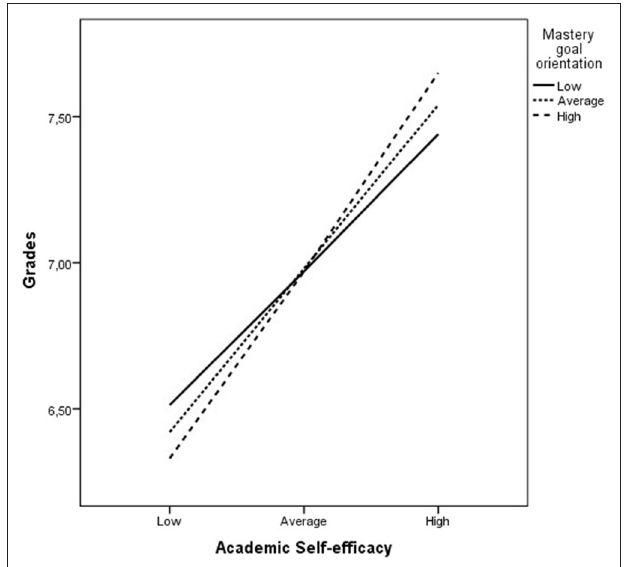
FIGURE 1 | Slopes